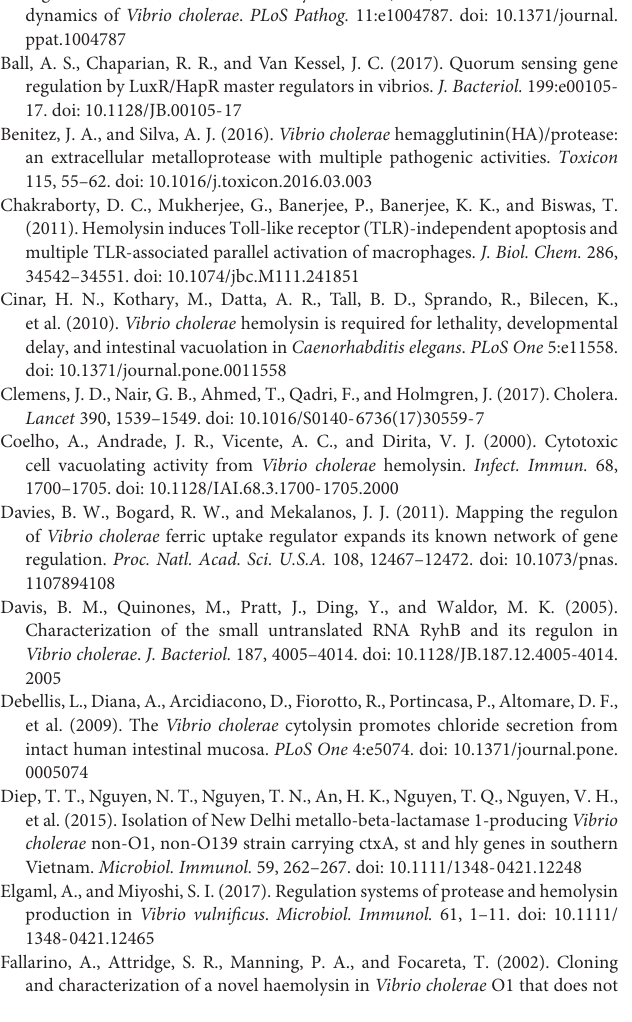
Figueroa-Arredondo, P., Heuser, J. E., Akopyants, N. S., Morisaki, J. H., Giono- Cerezo, S., Enríquez-Rincón, F., et al. (2001). Cell vacuolation caused by